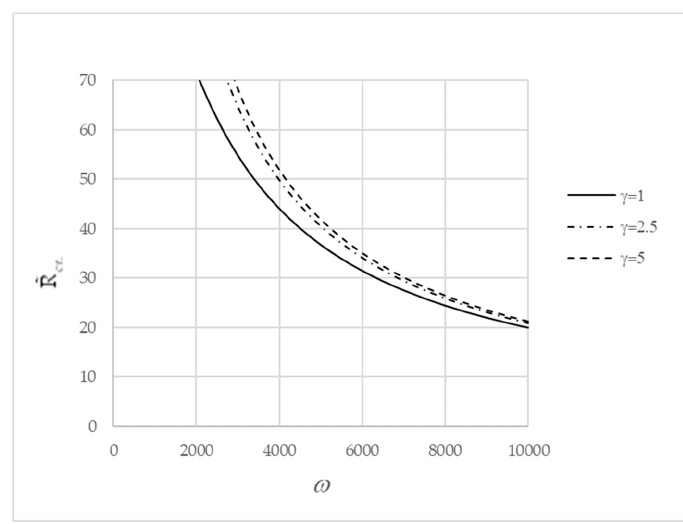
Figure 4. Critical Rayleigh number versus scaled Vadasz number at selected values of vibration frequency (Case 4: A = 1.5).